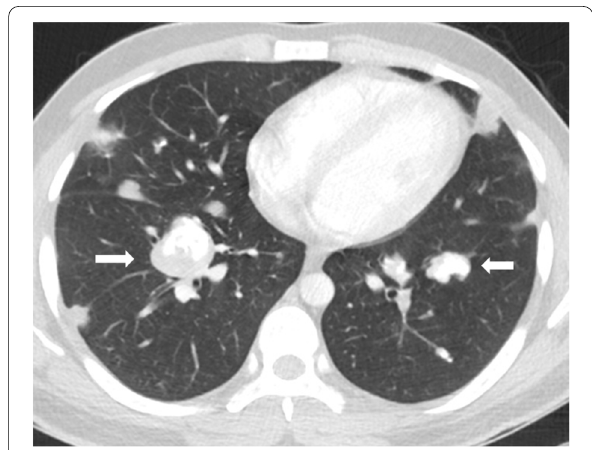
Fig. 1 Bilateral metastatic pulmonary deposits